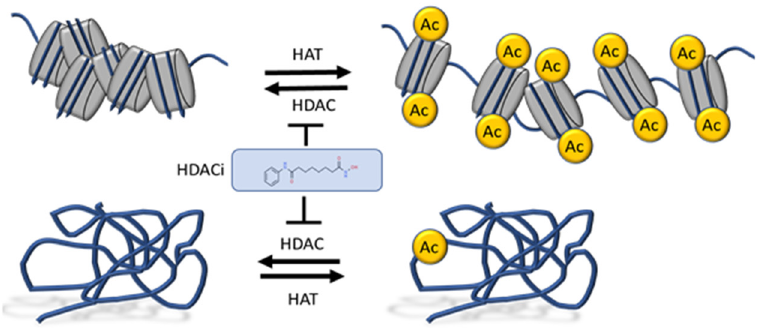
Figure 1. A schematic depicting how HDAC inhibitors modulate histone acetylation in relation to chromatin structure and acetylation of non-histone proteins. HAT: Histone Acetyltransferase; HDAC: Histone deacetylase; HDACi: Histone deacetylase inhibitors